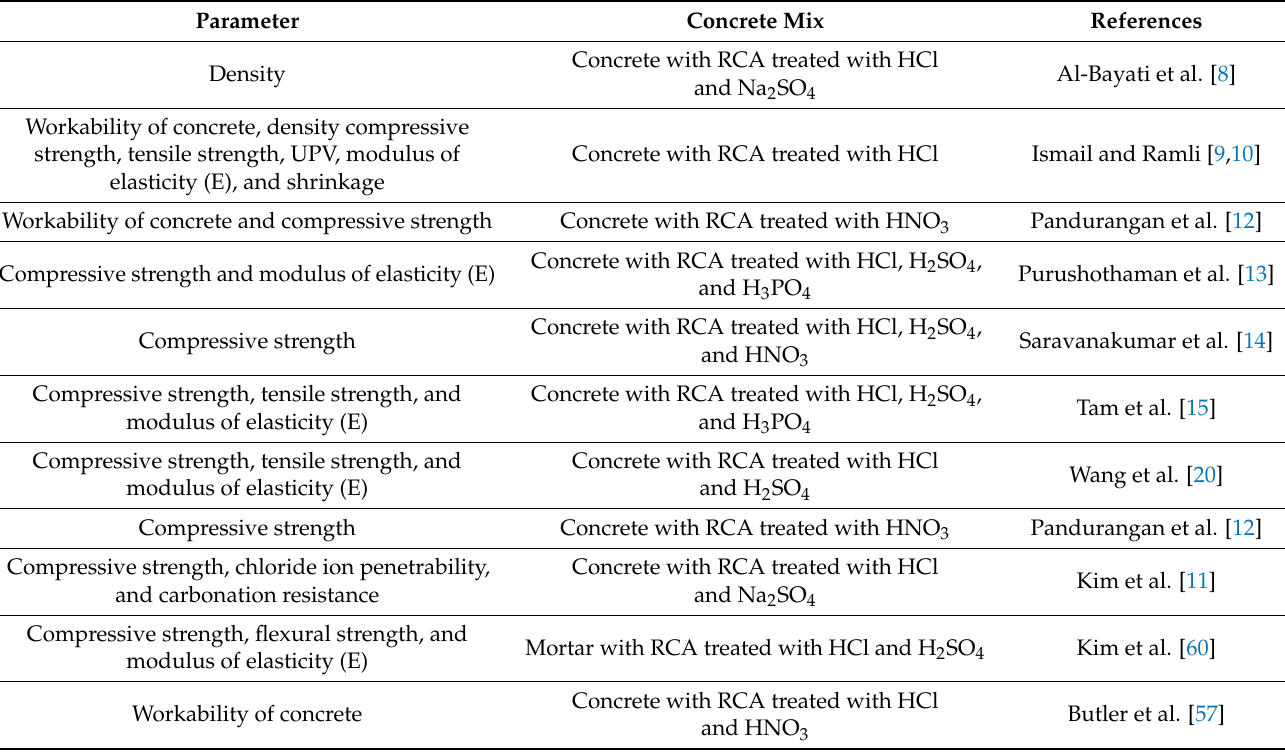
Table 2. Summary of measurements of fresh-state properties, mechanical properties and